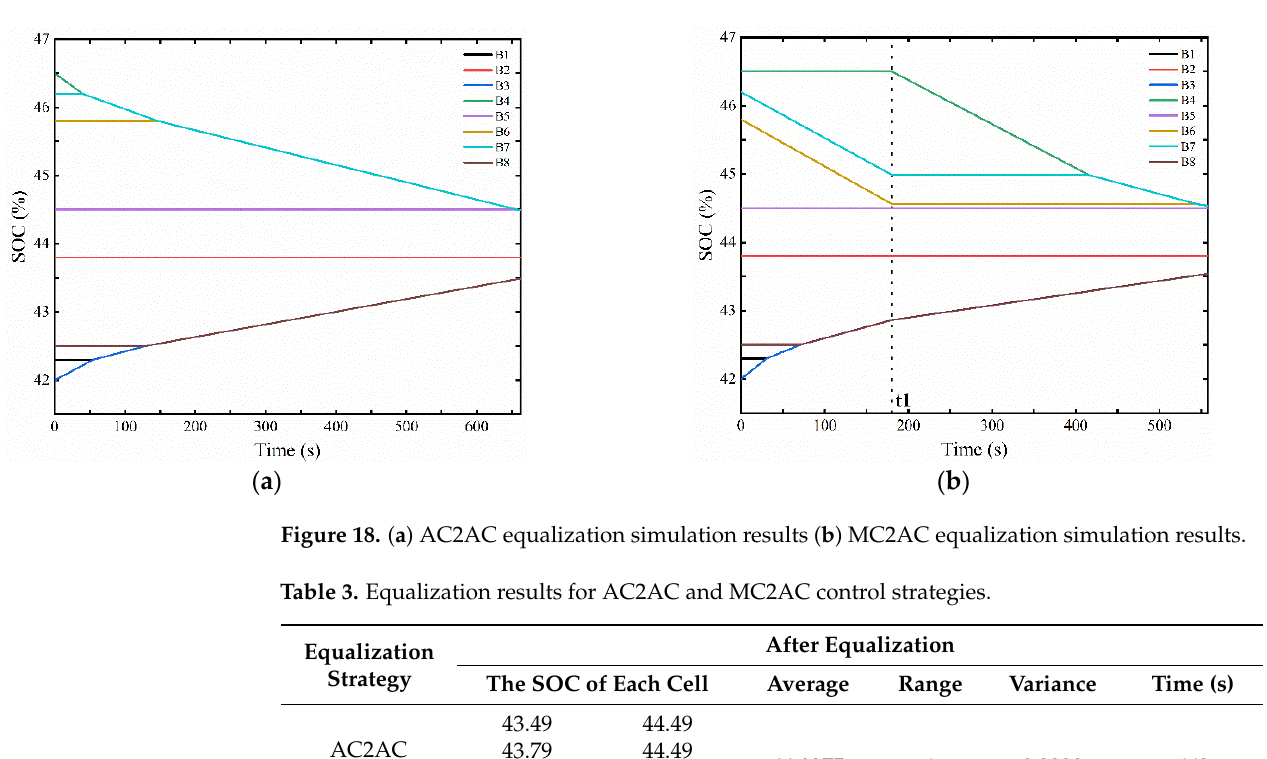
Figure 17. Battery pack energy state distribution.